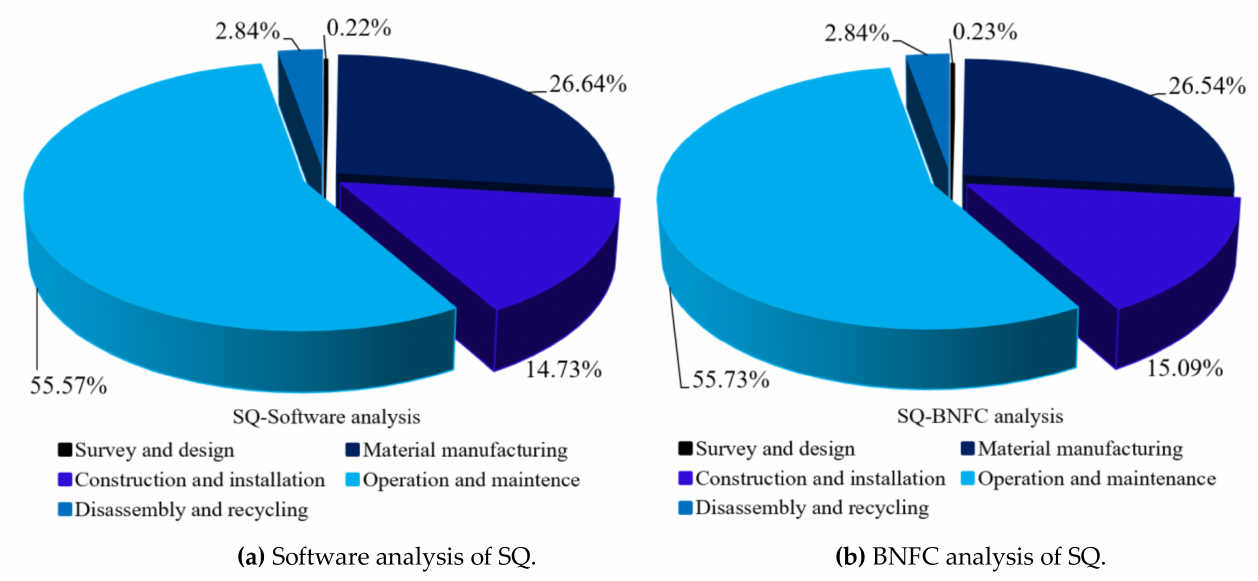
Figure 7. Comparison diagram of research and analysis conclusions of SQ’s contribution to the environment.